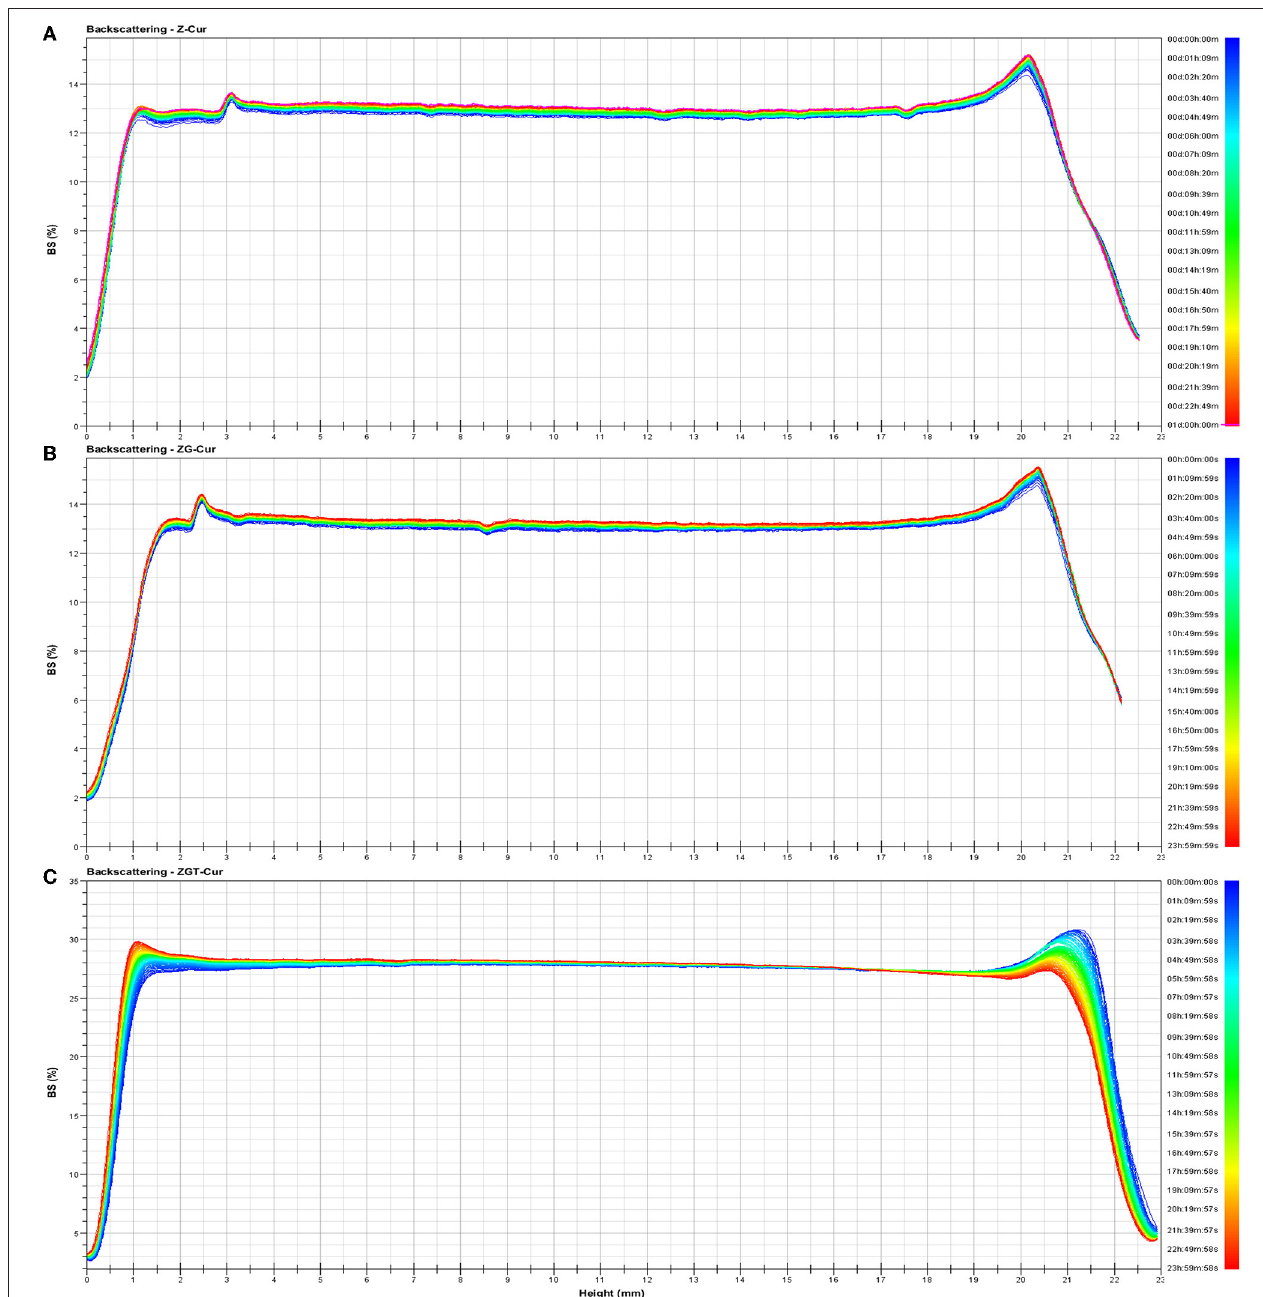
FIGURE 4 | Backscattering changes of Z- curcumin (Cur) (A) , ZG-Cur (B) , and ZGT-Cur (C) composite particle dispersions. Moreover, x-axis means height (mm), y-axis means BS (%).